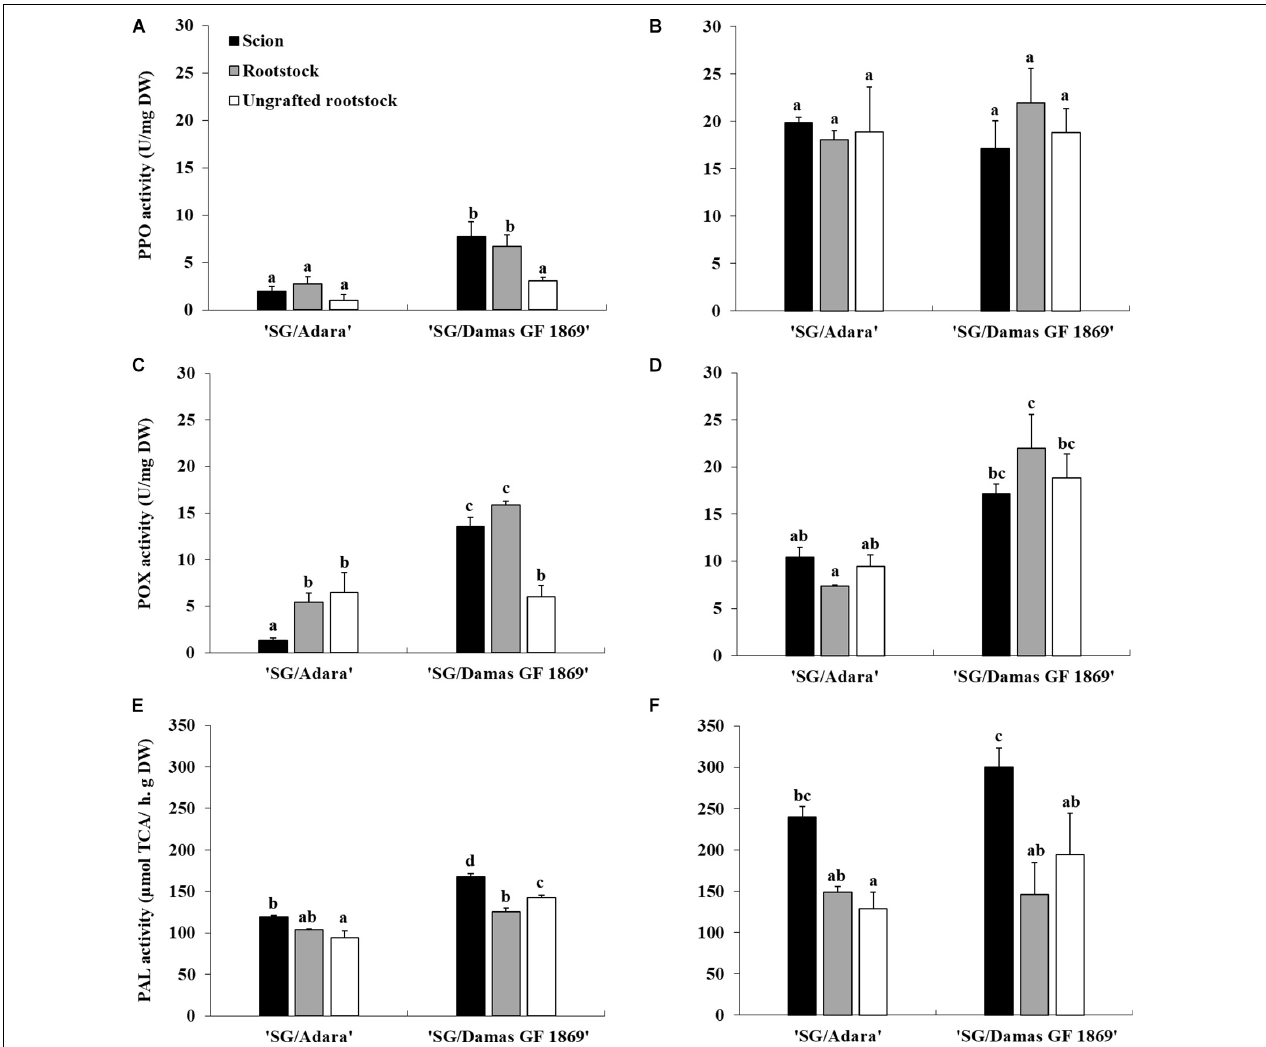
FIGURE 3 | Enzymatic activities of PPO, POX and PAL in the scion and rootstock of the compatible (“SG/Adara”) and incompatible (“SG/Damas GF 1869”) graft combinations, and ungrafted rootstocks [ (A,C,E) October 2017; (B,D,F) June 2018]. Vertical bars represent the mean ± SE ( n = 3 replicates) 3 years after grafting. For each graph, abc Mean values are significantly different at the P ≤ 0.05 level according to Duncan’s Multiple Range